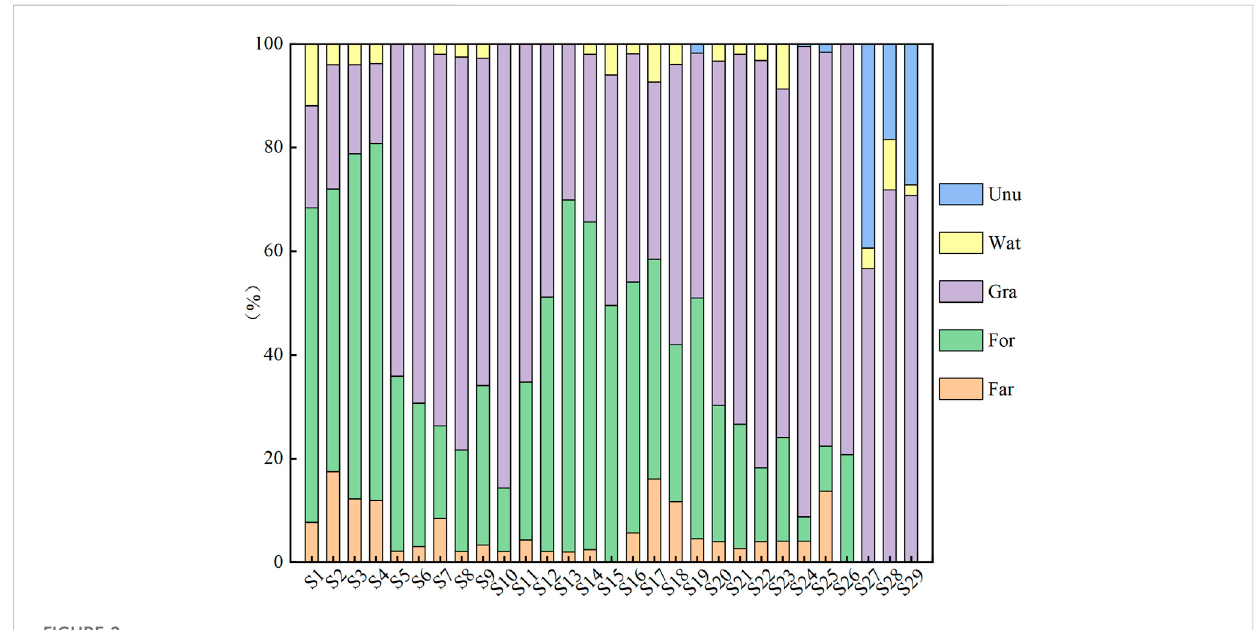
FIGURE 2 The proportion of LUT in 4,000 m buffer